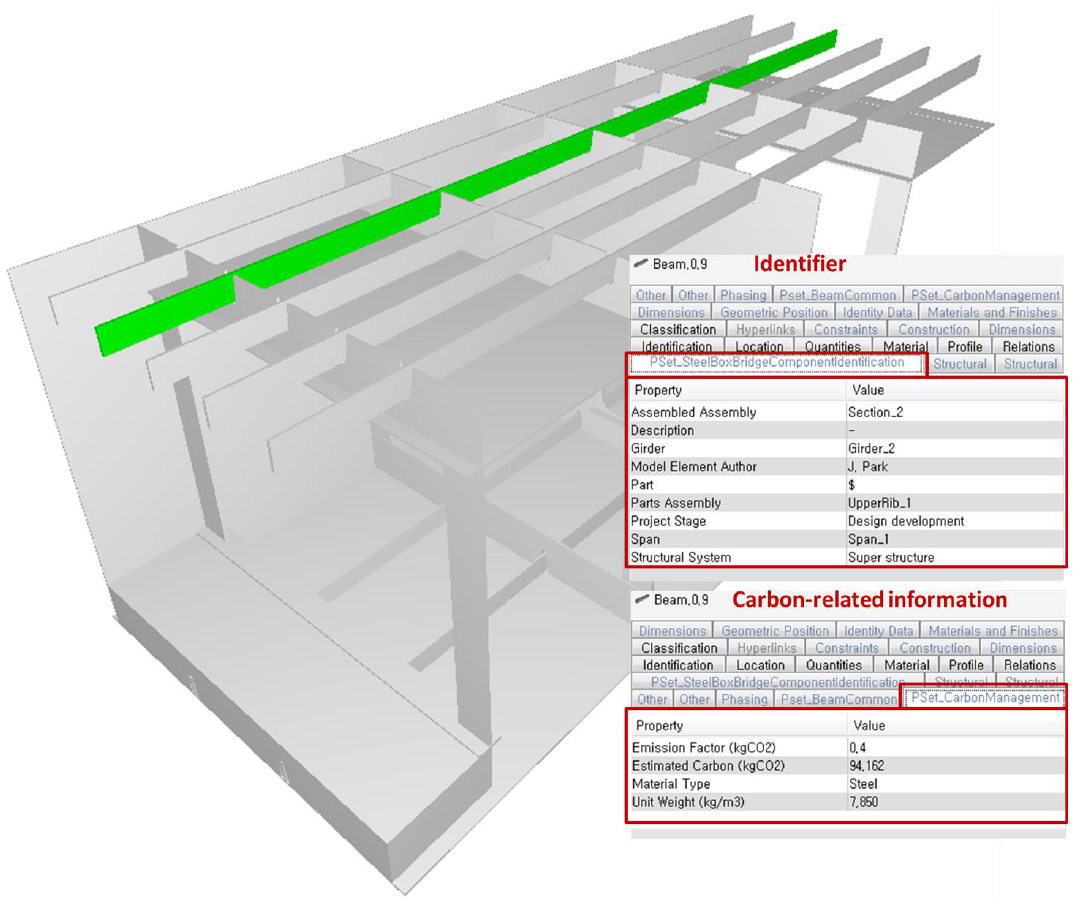
Figure 14. IFC-based information model including carbon-related information.